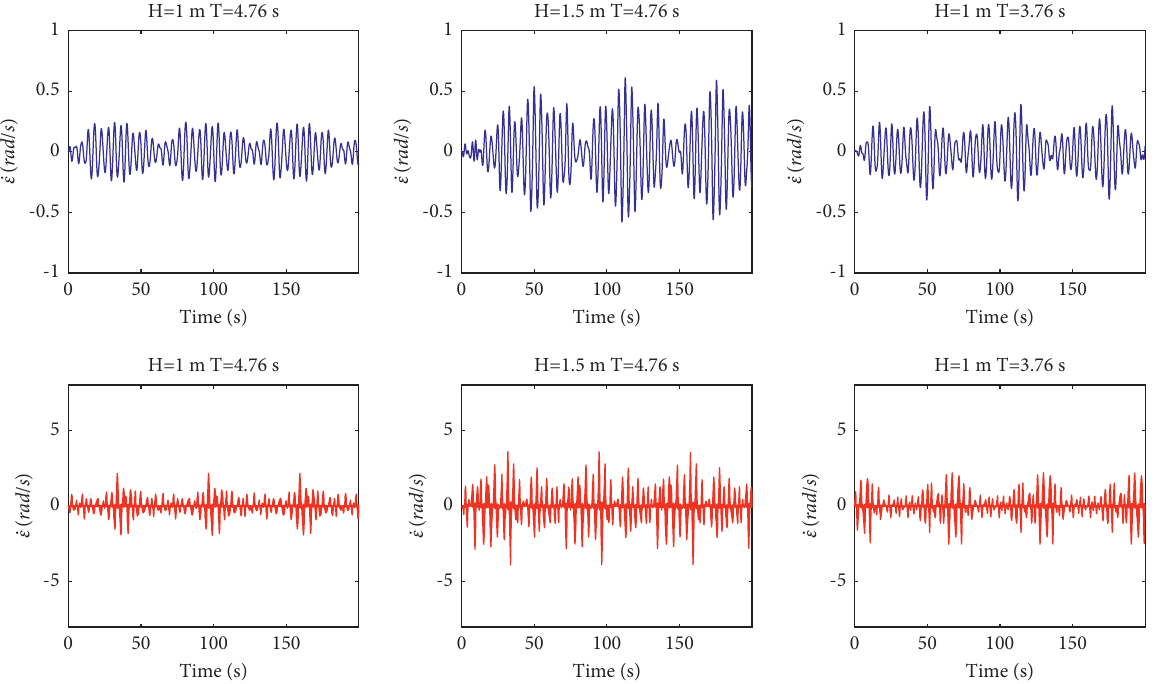
Figure 5: The precession angular velocity response comparison of the gyroscopic system under the random wave circumstance using LQR and NMPC, respectively. The red curve represents the NMPC controller, and the blue curve represents the LQR controller.